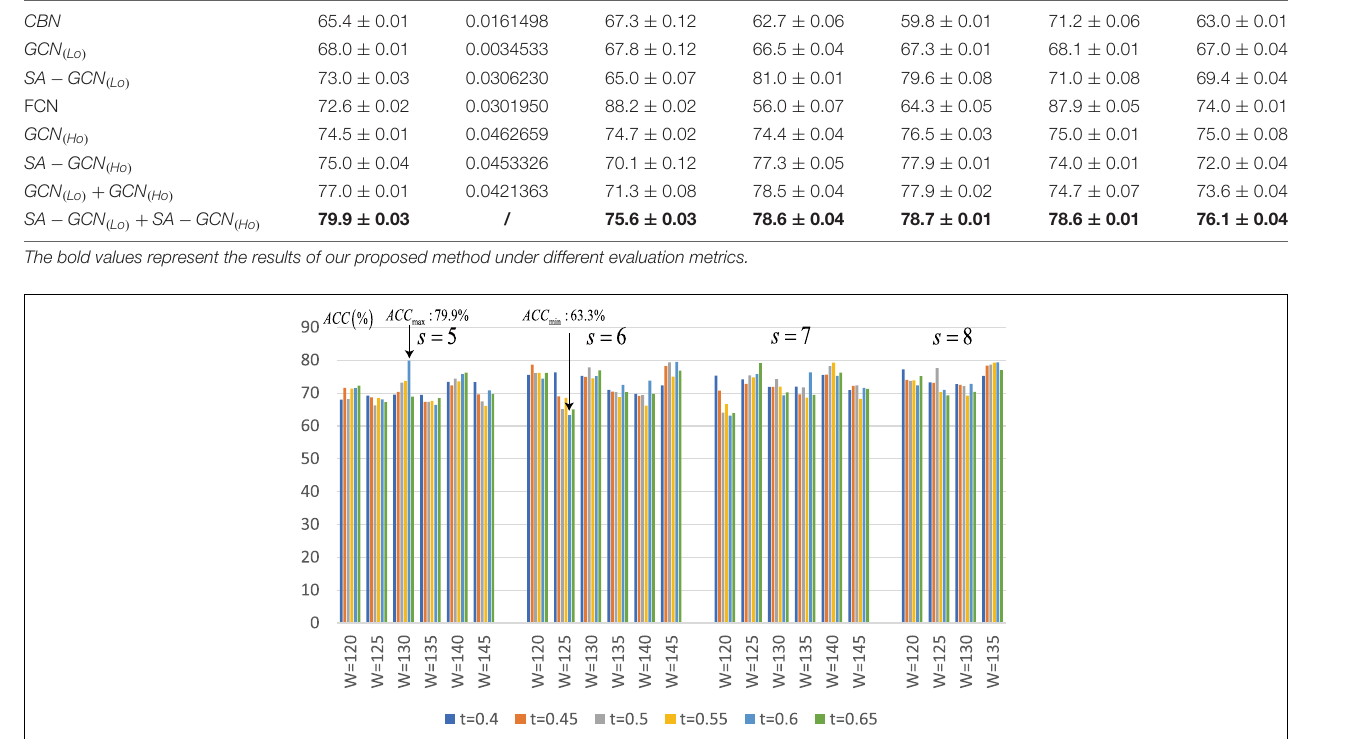
TABLE 2 | ASD classification results with different feature strategies. Model